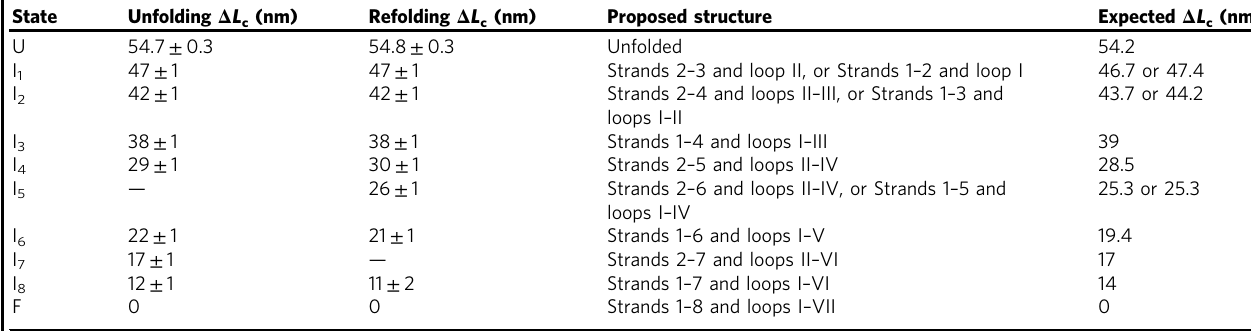
Table 1 States observed during native unfolding and refolding of monomeric apo-SOD1 State Unfolding Δ L c